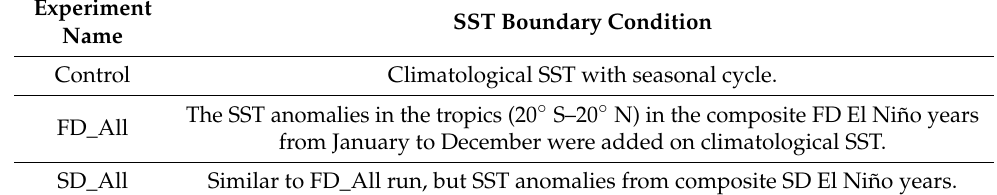
Table 2. Descriptions of control and sensitivity experiments.